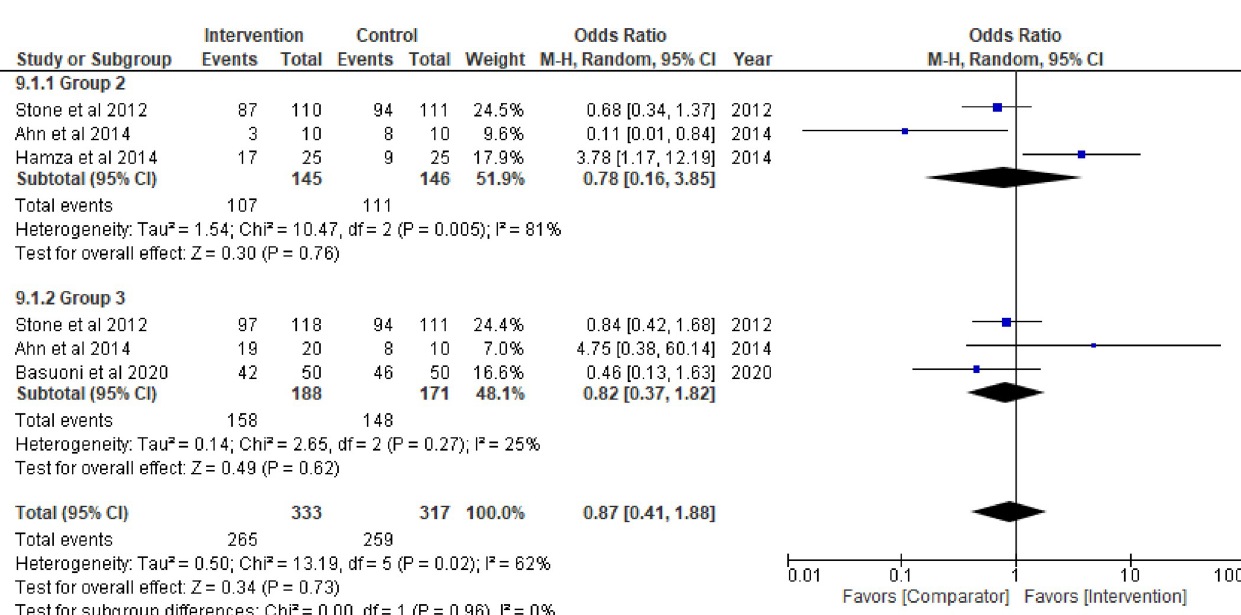
PLOS ONE | https://doi.org/10.1371/journal.pone.0263270 May 5,